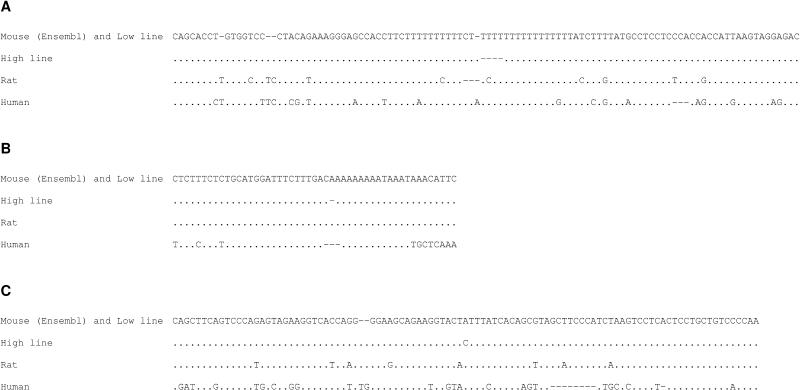
Polymorphisms between High- and Low-Line-Derived Chr X(A) 80 bp from the stop codon of Gpc3 in the 3′ UTR.(B) 332 bp from the stop codon of Gpc3 in the 3′ UTR.(C) 1,455 bp downstream of Gpc3.Sequence in common with reference mouse sequence [20] is denoted by dots.